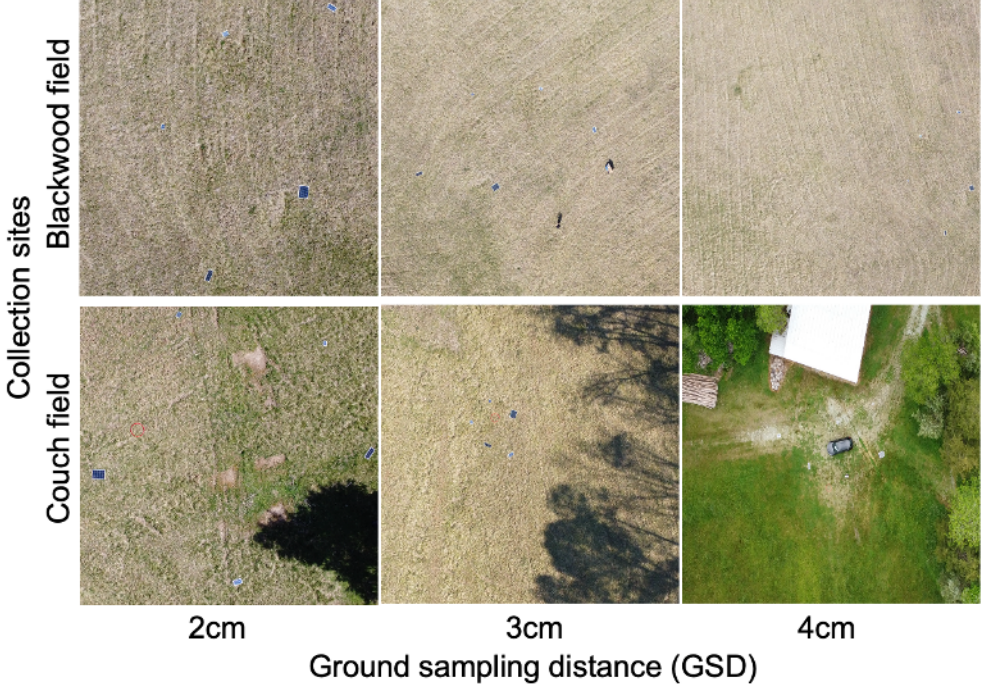
Figure 1. Example imagery in our dataset collected. First row contains imagery taken in Blackwood Field. Second row contains imagery taken in Couch Field. Left column has GSD of 2 cm, middle column has GSD of 3 cm, right column has GSD of 4